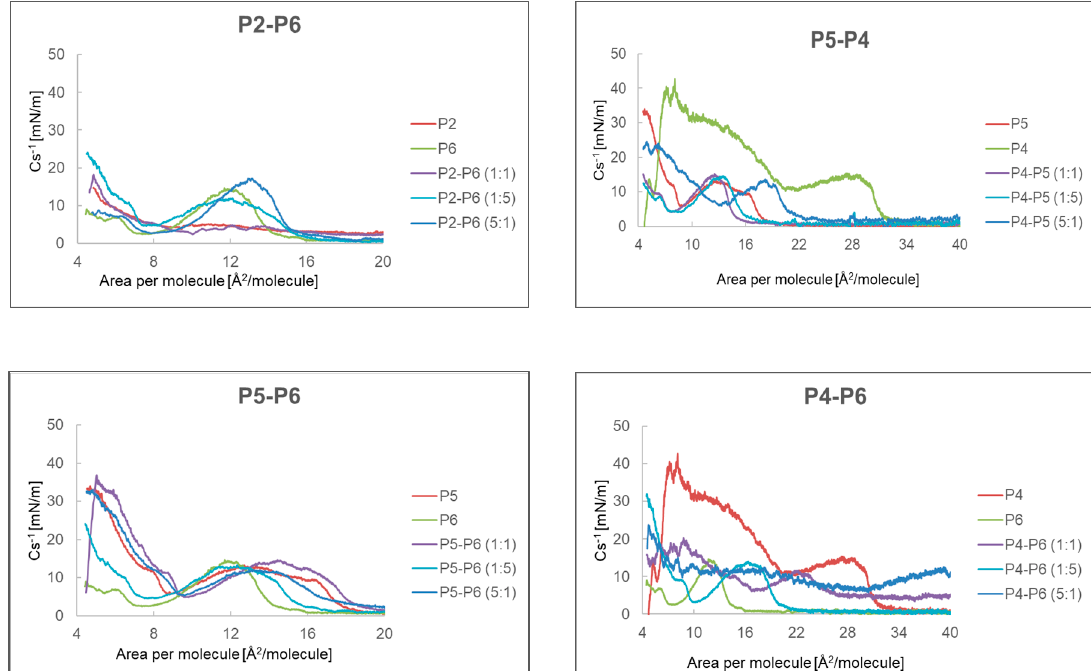
Figure 9. Dependence of the compressibility coefficient depending on the surface area per particle of the mixtures P2, P4–P6 peptide in different proportion.